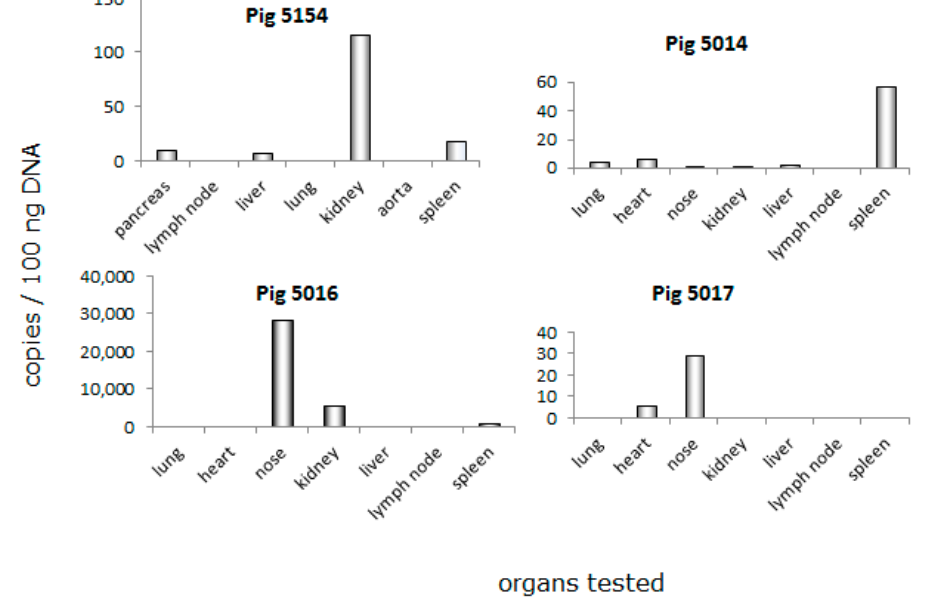
Figure 2. Real-time PCR analysis of PCMV distribution in different organs of donor animal 5154, and other animals (5014, 5016, and 5017). DNA was isolated and tested for the copy number of PCMV. Please note the differences in scaling of the y -axis.